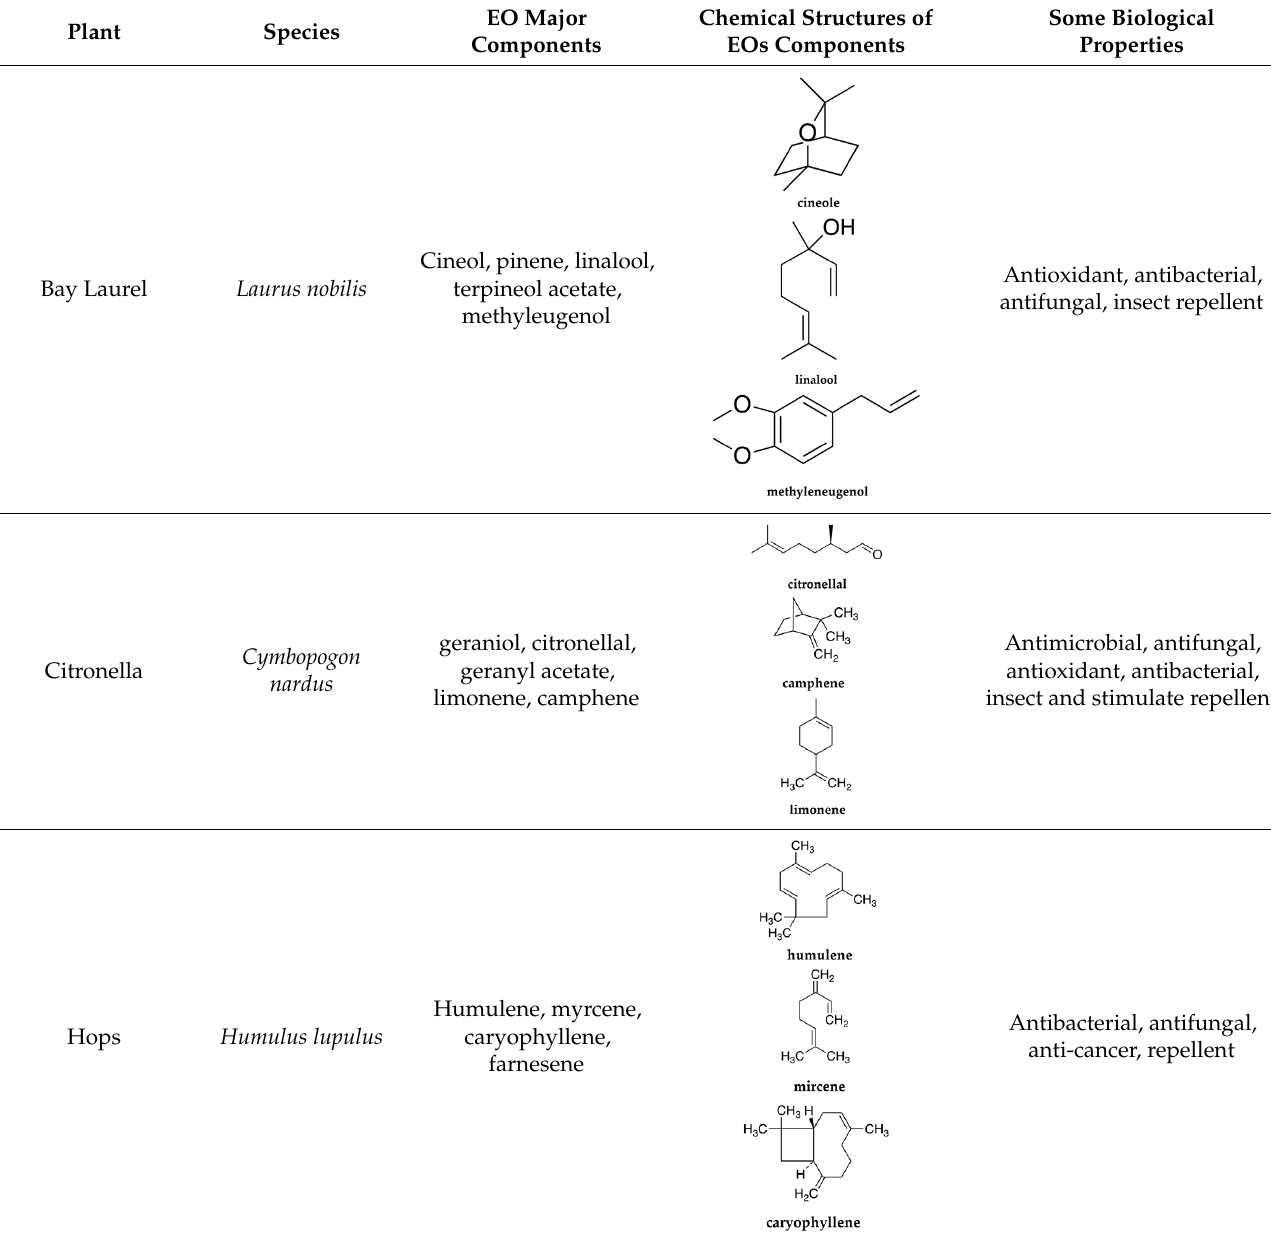
Table 3. Essential oil plants, species, and main components, and their molecular structure and biological properties.